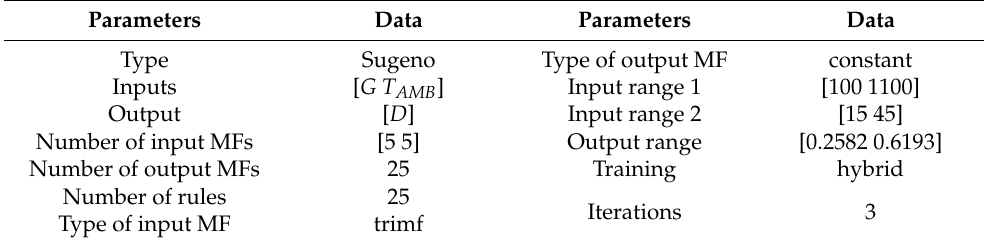
Table 6. The main parameters of the ANFIS algorithm with the G and T AMB input variables.